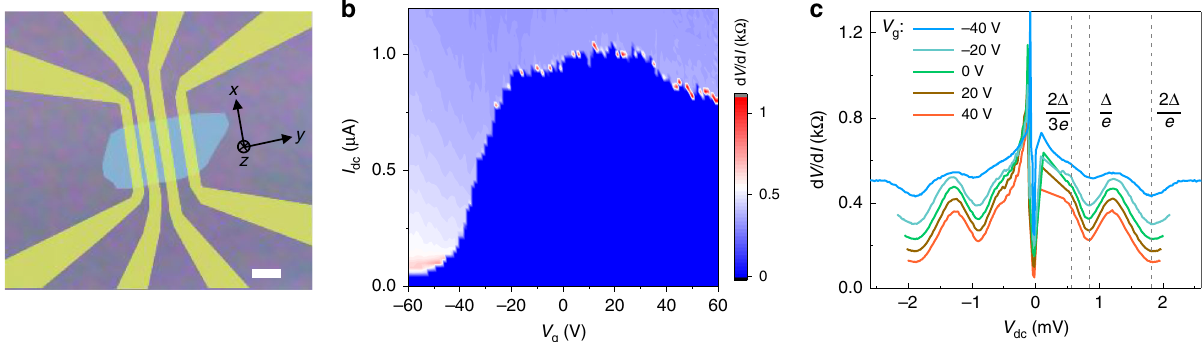
Fig. 1 Josephson effect in a Nb-Cd 3 As 2 -Nb junction. a Optical image of the Nb-Cd 3 As 2 nanoplate-Nb Josephson junctions. Scale bar, 2 μ m. b The color- scale differential resistance d V /d I as a function of gate voltage V g and d.c bias current I dc . c The d V /d I versus source-drain voltage V dc across the junction, showing the multiple Andreev re fl